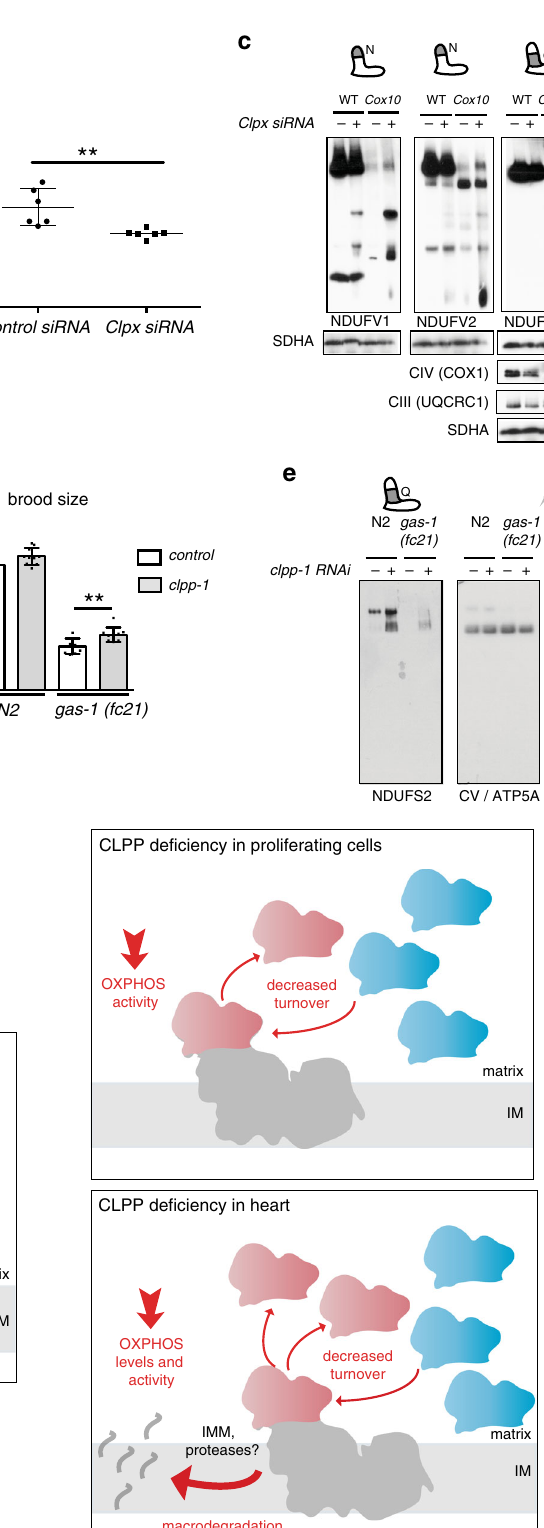
Nicotinamide adenine dinucleotide (NAD, Roche), dithiothreitol (DTT; Sigma), Carmustine (bis-chloroethylnitrosourea (BCNU, Sigma), aurano fi n (Sigma), myxothiazol (Sigma), potassium cyanide (Sigma), cycloheximide (Sigma), mitoparaquat (mitoPQ, Abcam), or respective vehicles at indicated concentrations and times. To determine the cell survival, the numbers of cells were estimated following the drug treatments (or respective mock controls) using the Countees Automatic Cell